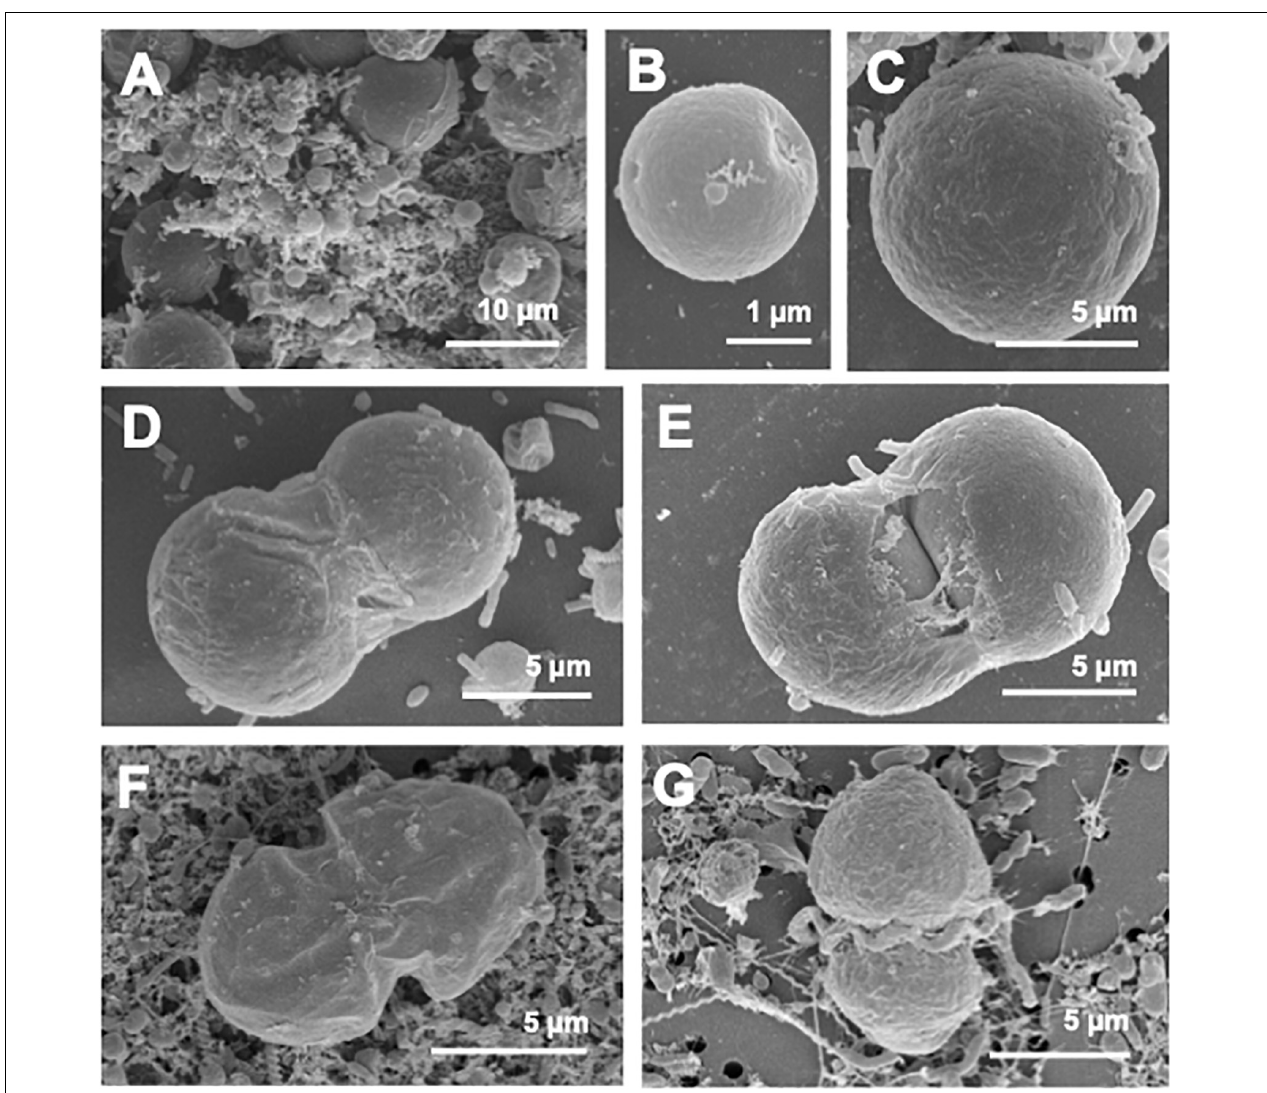
FIGURE 5 | SEM micrographs of different cellular stages observed in Symbiodiniaceae cultures. (A) C. tuberculata symbionts of both sizes. (B) Small coccoid cells observed in cultures. (C) Bigger coccoid stage. (D,E) Doublet, two different phases of bigger coccoid cells undergoing mitosis. (F,G) Motile flagellated